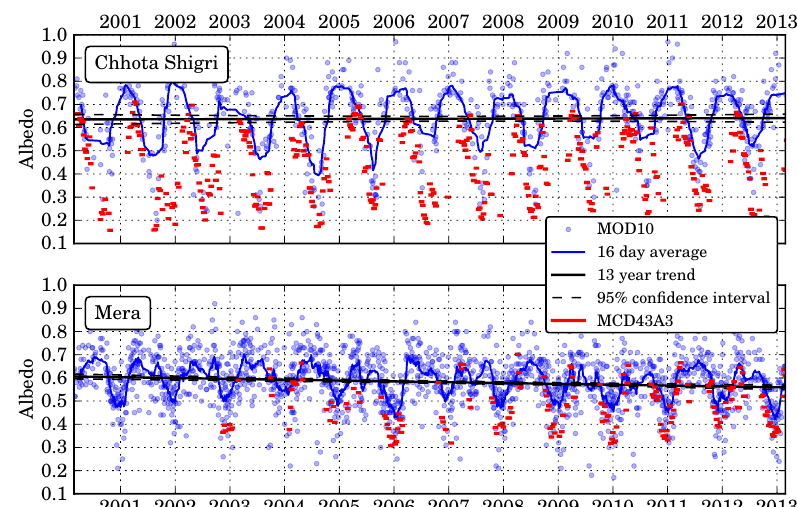
Figure 7. MOD10 daily albedo (light blue dots) and 10-day running average (solid blue line) for the highest pixel of Chhota Shigri Glacier (upper panel; pixel at 5191ma . s . l . ) and Mera Glacier (lower panel; pixel at 6008ma . s . l . ). The solid black line represents the 13year linear trend in albedo ( + 4 . 3 × 10 − 4 ± 7 × 10 − 5 yr − 1 for Chhota Shigri Glacier and − 3 . 6 × 10 − 3 ± 3 × 10 − 5 yr − 1 for Mera Glacier). The red dots are the MCD43 8day albedo constructed from multiangle acquisitions over 16 days. Only 22% of MCD43 data points correspond to good quality products on Chhota Shigri Glacier and only 4% on Mera Glacier. Note that many data points acquired during monsoon time above Mera Glacier, or during winter time above Chhota Shigri Glacier, probably correspond to undetected cloudy pixels.